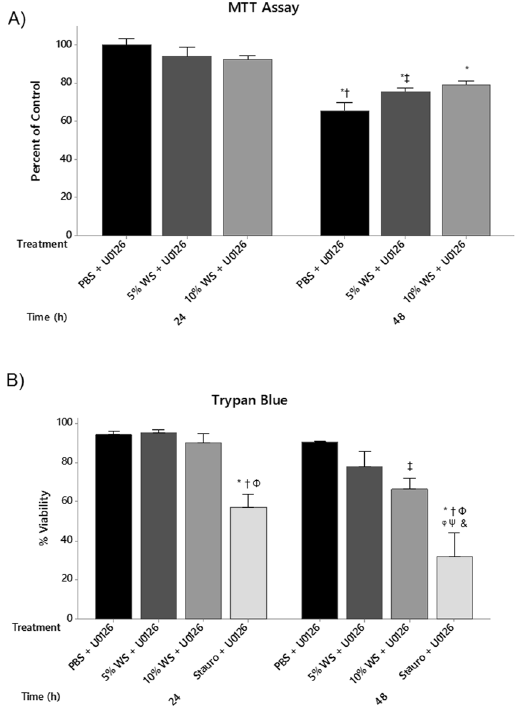
Figure 8. U0126 Pre-Treatment Does Not Reduce Cell Viability. ( A ) MTT and ( B ) trypan blue exclusion were used to assess the effects of U0126 and wood smoke on A549 cell viability. Neither assay detected a reduction in cell viability among wood smoke exposed groups. Staurosporine was used as a positive control for reduced viability. MTT ( * P < 0 . 01 vs. 24 h Untreated; † P < 0 . 001 vs. 24 h 5% WS + U0126 and 24 h 10% WS + U0126; ‡ P < 0 . 05 vs. 24 h 5% WS + U0126 and 24 h 10% WS + U0126). Trypan blue exclusion ( * P < 0 . 01 vs. 24 h Unt + U0126; † P < 0 . 01 vs. 24 h 5% WS + U0126; ‡ P < 0 . 05 vs. 24 h 5% WS + U0126; Φ P < 0 . 01 vs. 24 h 10%WS + U0126; ϕ P < 0 . 05 vs. 48 h 10% WS + U0126; Ψ P < 0 . 01 vs. 48 h 5% WS + U0126; & P < 0 . 01 vs. 48 h Unt + U0126; n = 3). Statistical differences were determined using a two-way ANOVA followed by a Tukey’s post-hoc test. Data presented as mean ±